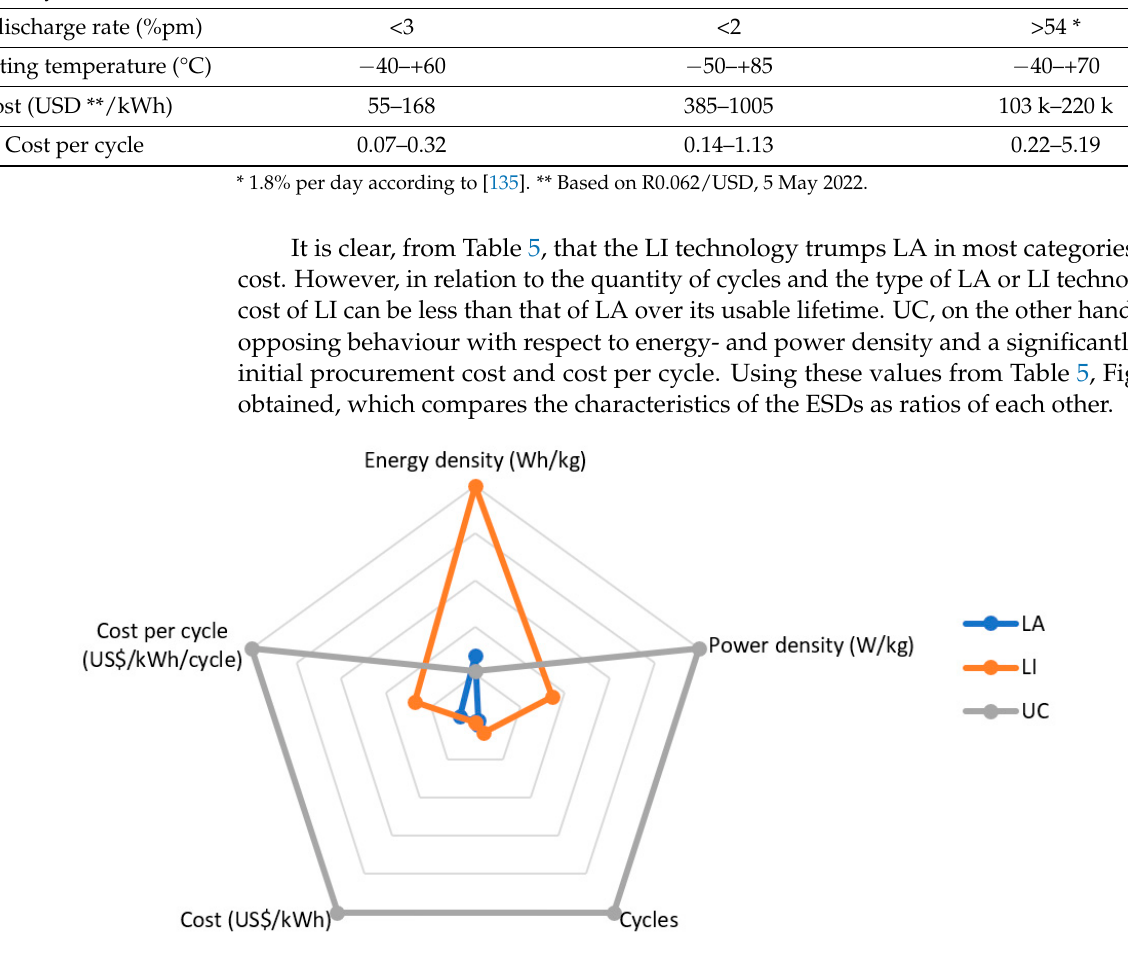
Figure 3. Radar graph comparing lithium-ion and lead acid characteristics, adapted from [24].